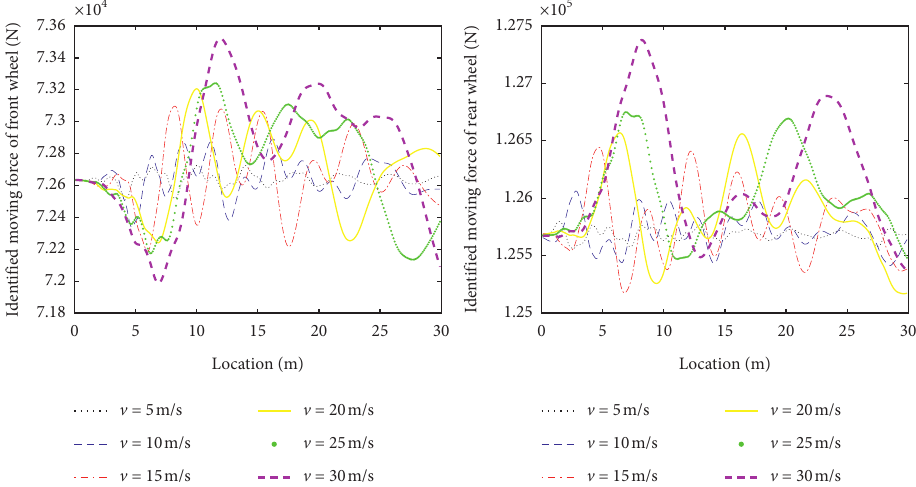
Figure 18: Moving force at different vehicle